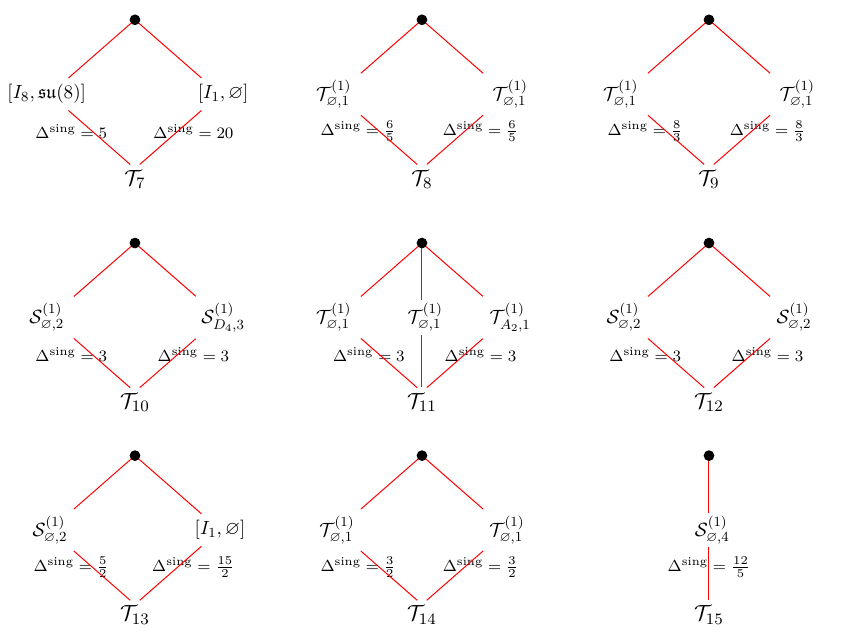
Figure 3 . Hasse diagrams for the CB of the candidate new theories T i for i = 7 , . . . , 15 , as output by the